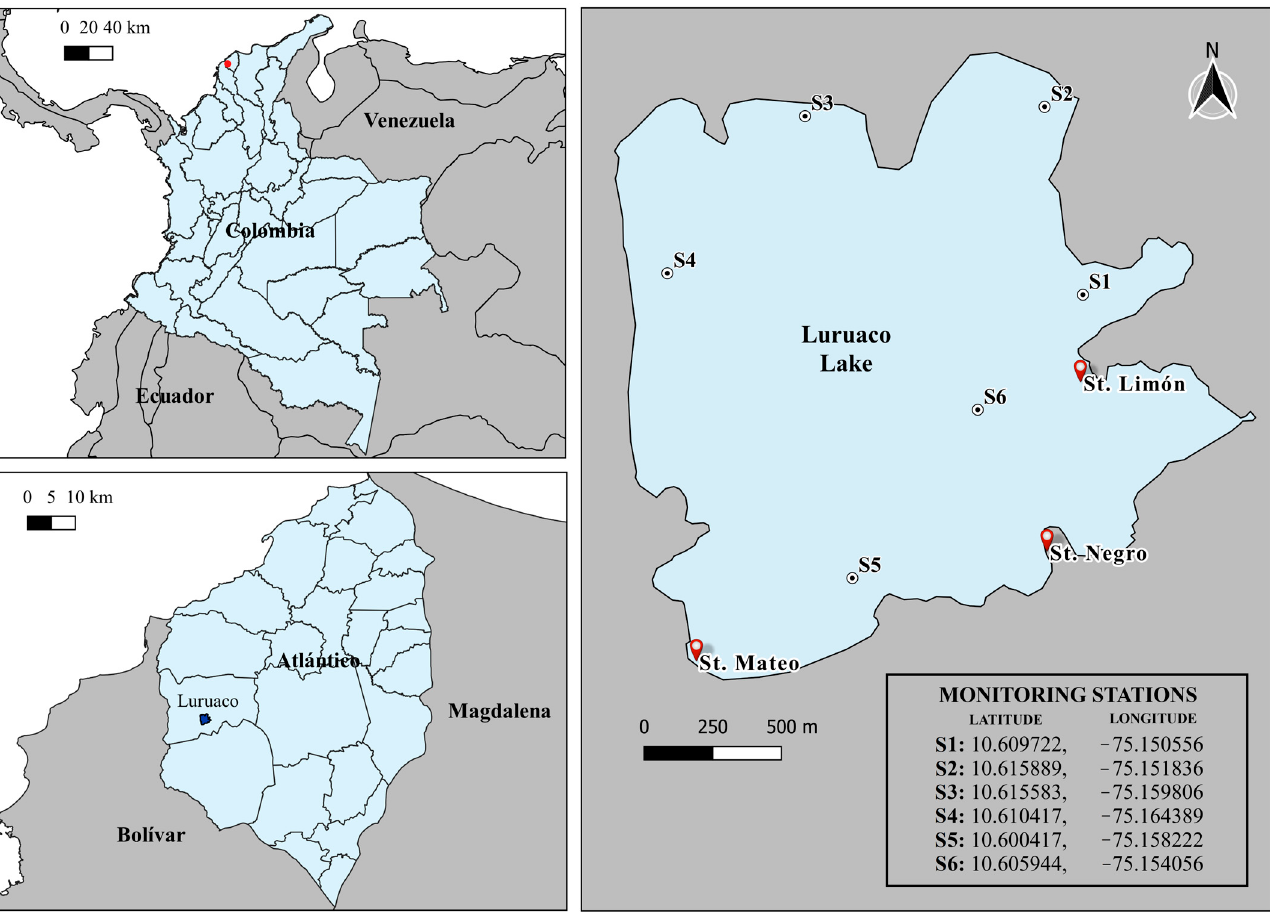
Figure 1. Geographical location of Luruaco Lake, Colombia. Monitoring stations and the mouths of the Lim ó n, Mateo, and Negro